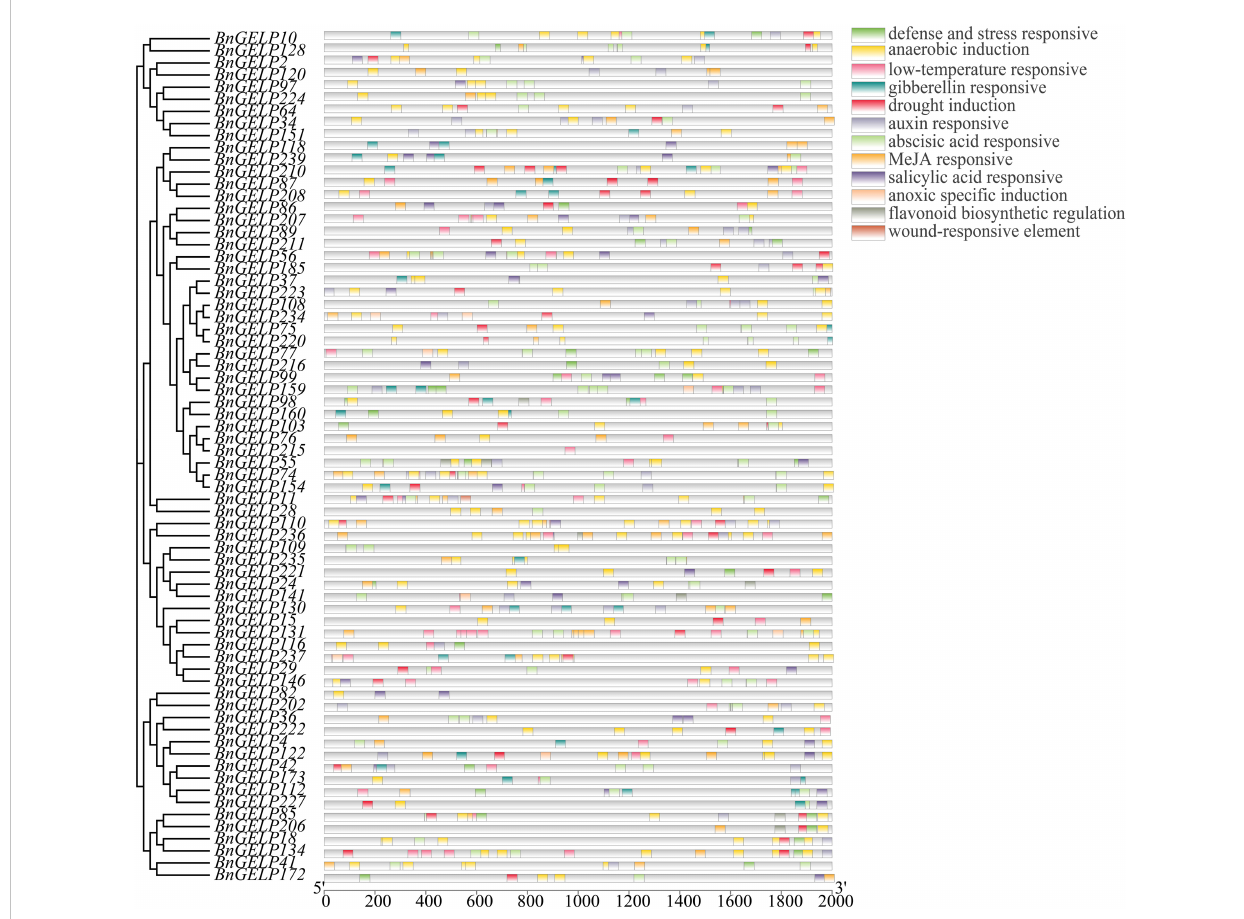
FIGURE 8 Predicted cis -elements in the promoter regions of the clade 5 BnGELP genes. The name of each regulatory element is shown on the right panel, with different colored boxes representing different cis -elements. The relative location of each element on each promoter can be estimated by the scale at the bottom.